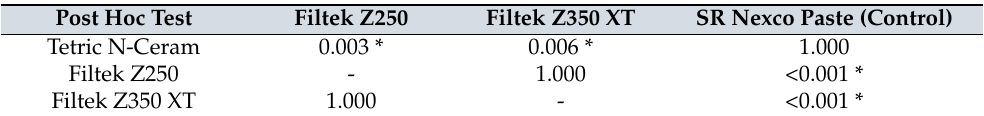
Table 5. Multiple comparisons between the types of additional dry heat curing resin composites, according to the post hoc test with Bonferroni correction.